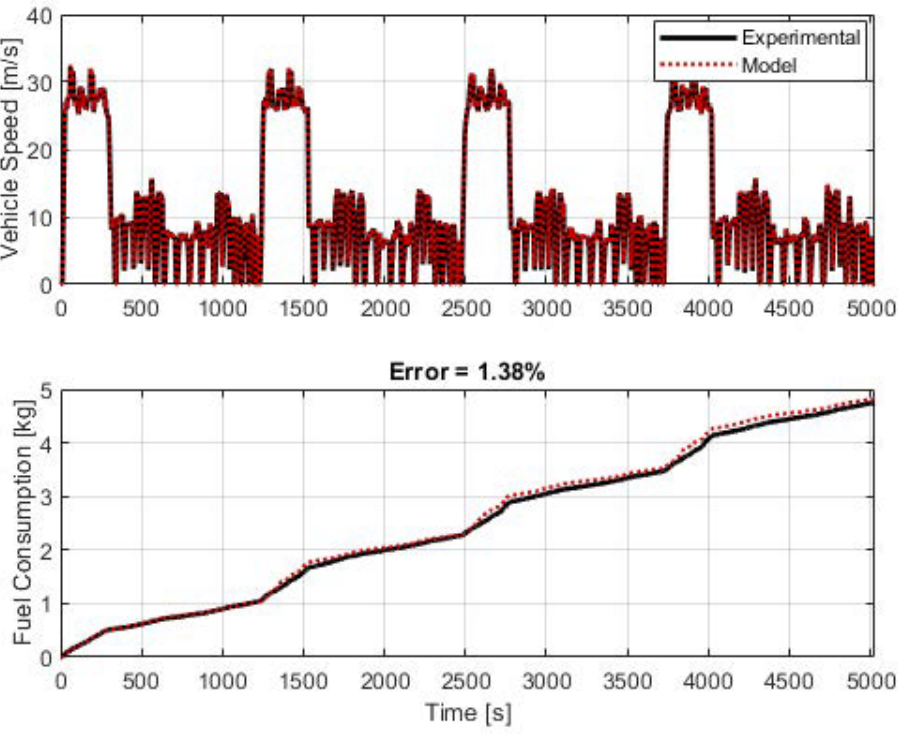
Figure 3. Comparing experimental and simulated